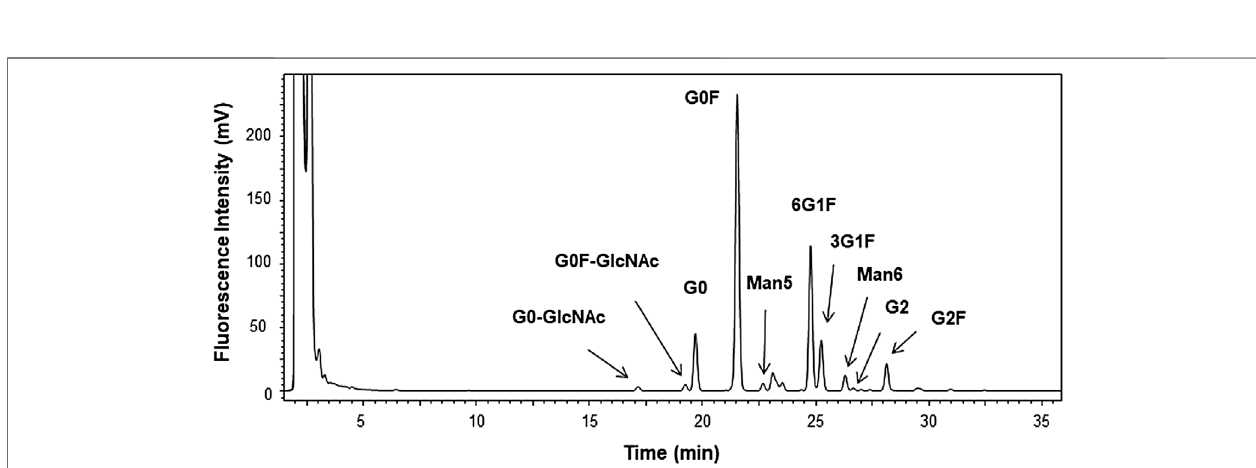
FIGURE 5 | Mass spectrum of scFc fragment obtained by IdeS digestion. Peaks are shown as averaged mass. The calculated and observed masses are summarized in Supplementary Table S3 .